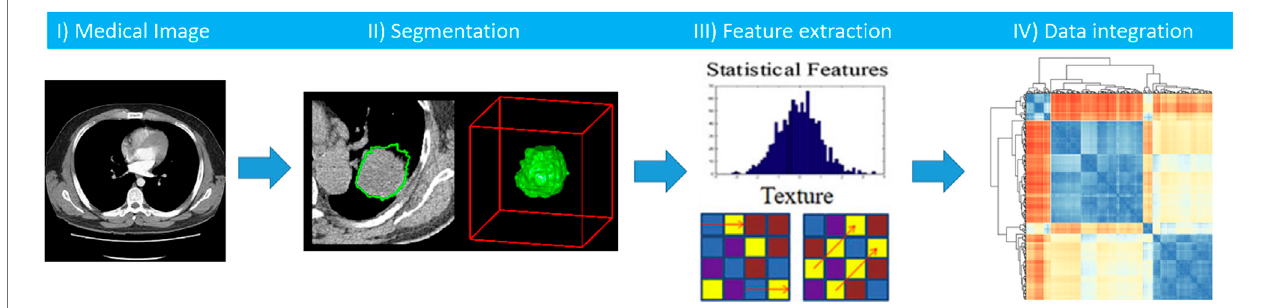
FIGURE10| Work fl owofradiomicsanalysisincludessegmentationofamedicalimage, featuresextraction,andintegrationofradiomicsfeatureswithotherclinical biomarkers.